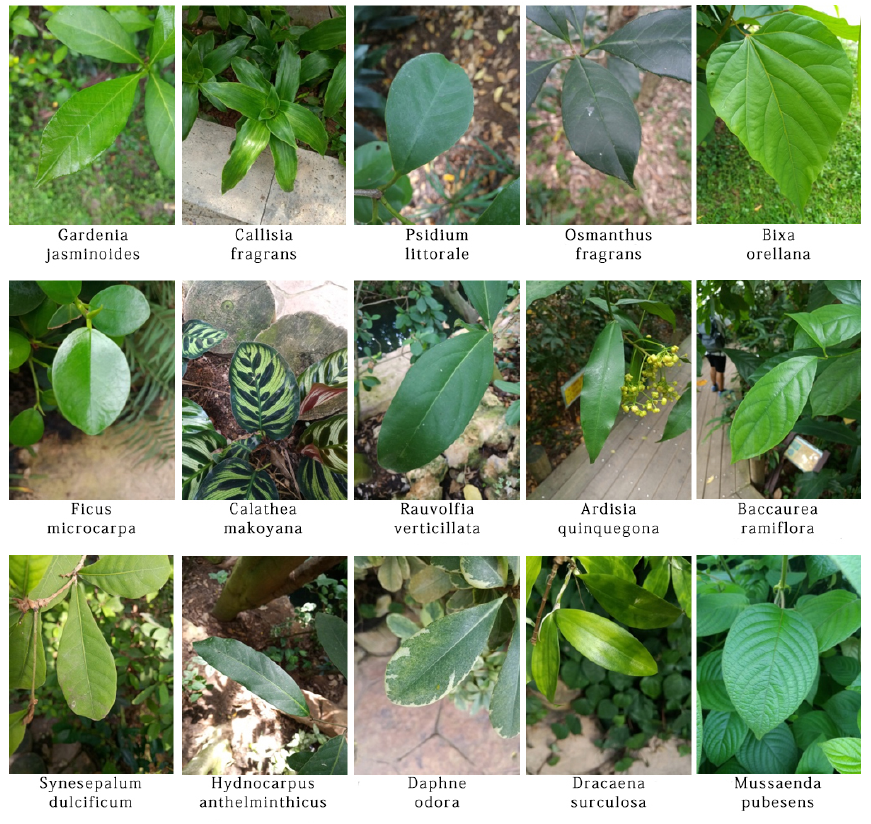
Figure 1. The collection of the 15